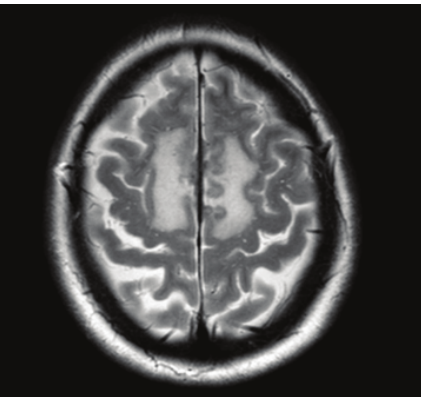
Figure 4: Further axial T2 study 3 months later (08/2013) showing some improvement in extent of T2 abnormality and oedema; dural thickening and enhancement